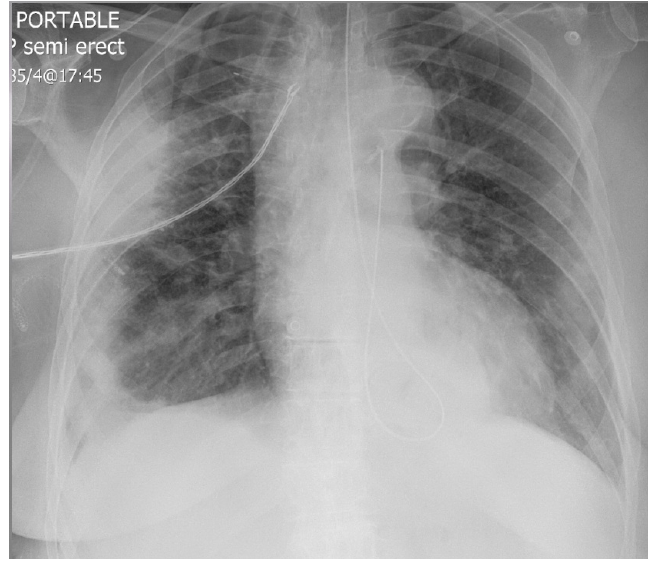
Figure 3. Example of X-ray